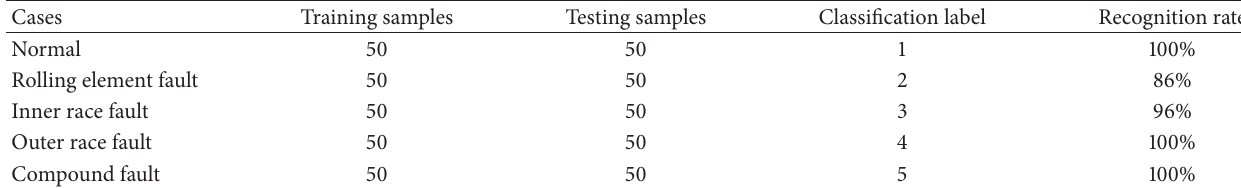
Table 3: Bearing recognition results.